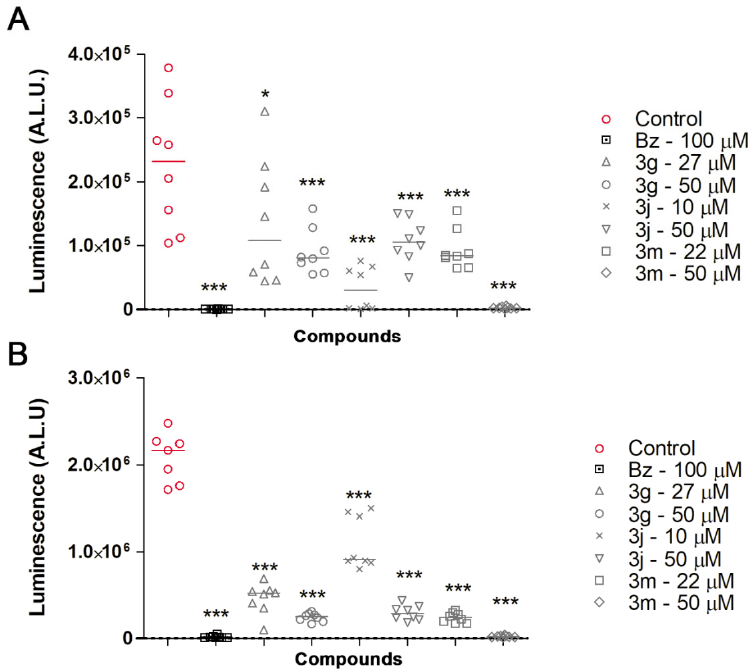
Figure 3. T. cruzi washout assay with promising pyrazole derivatives and Bz. Luminescence signal, represented as arbitrary luminescence unit (ALU), of Vero cell cultures infected with T. cruzi treated with 3g , 3j , 3m or Bz, using IC 90 or 50 µ M concentrations, after washing and 72 h incubation in the absence of the compounds. ( A ) Analysis of viable parasites (trypomastigotes) released in the culture supernatants. ( B ) Infection profile of Vero cell monolayers. (*) Statistically significant in relation to the untreated group using the One ‐ Way ANOVA test, being p < 0.05 (*) and p < 0.001 (***). Treatment with 50 μ M of 3g , 3j , and 3m (2–5 times IC 90 ) revealed the efficacy of 3m ,